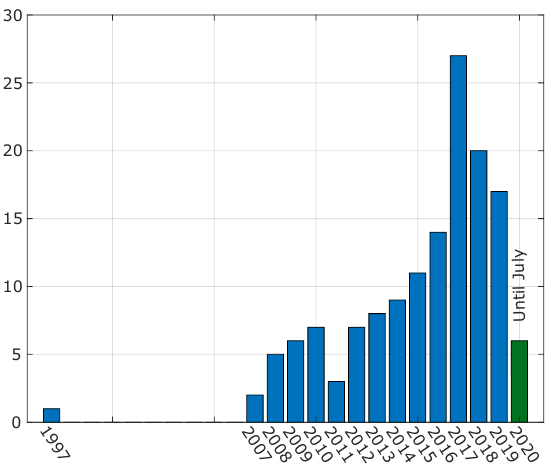
Figure 2. Number of studies published per year on the